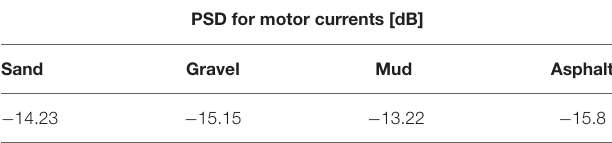
TABLE 3 | Typical values for the PSD of body vertical acceleration. TABLE 4 | Power spectral